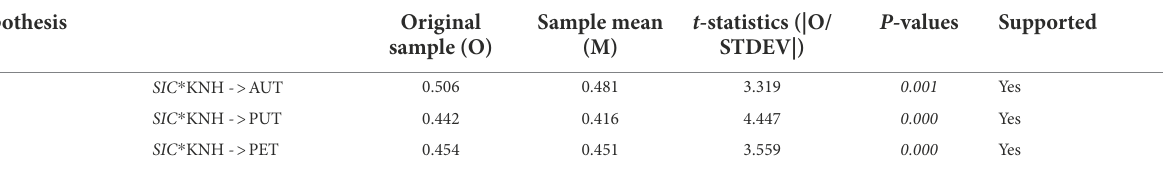
TABLE 10 Moderation analysis 1.